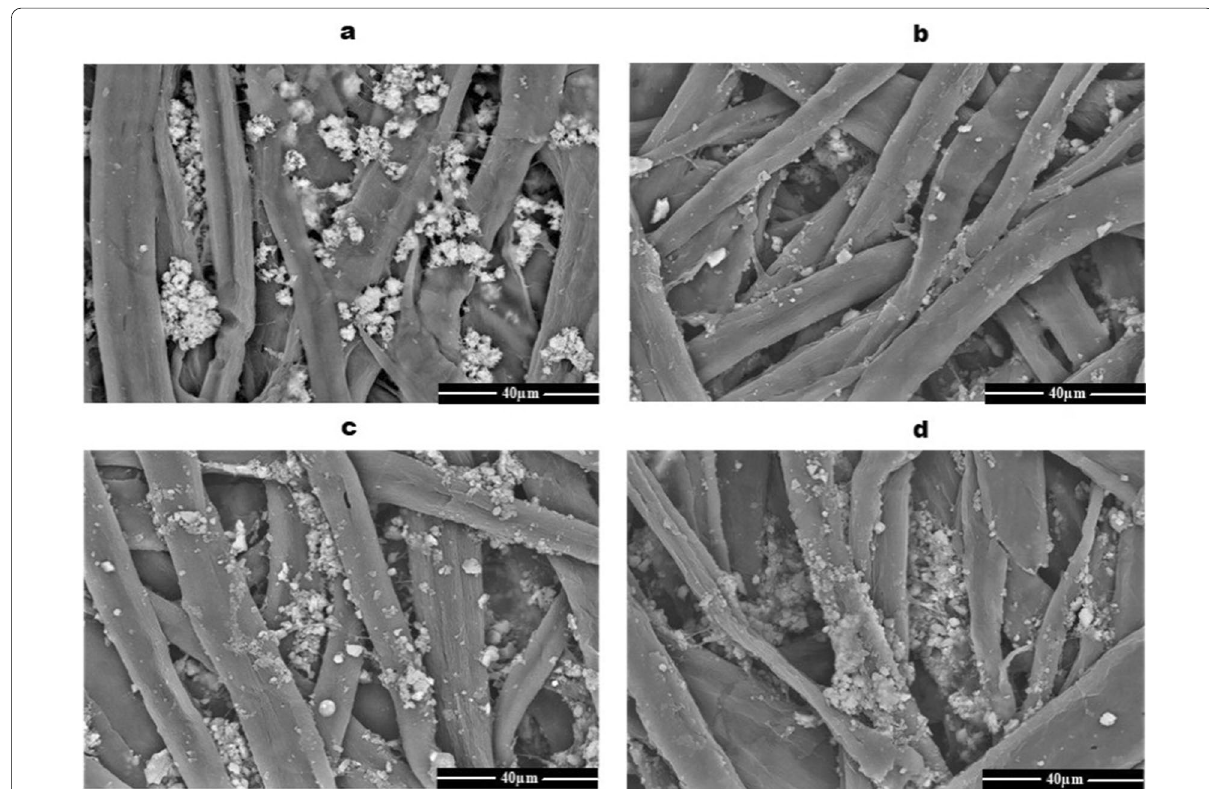
Fig. 7 SEM micrograph of the paper structure after exposure to the dry heat treatments. Control ( a ), 100 °C ( b ), 150 °C ( c ), and 200 °C ( d